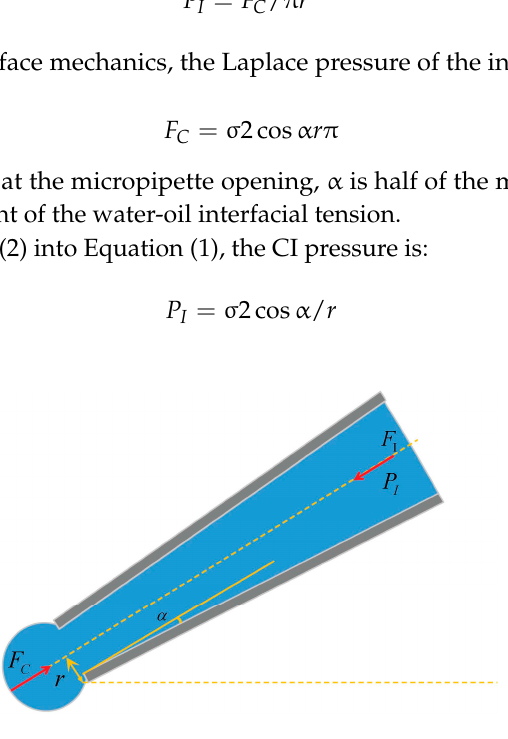
Figure 1. Schematic of the critical injection (CI) model.